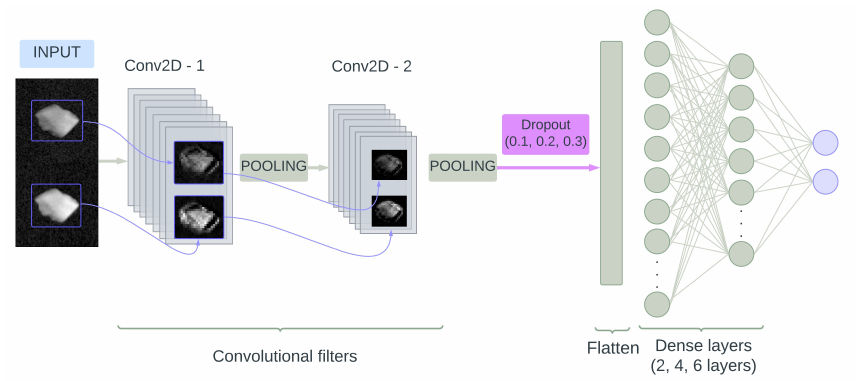
Figure 2. Overview of the model